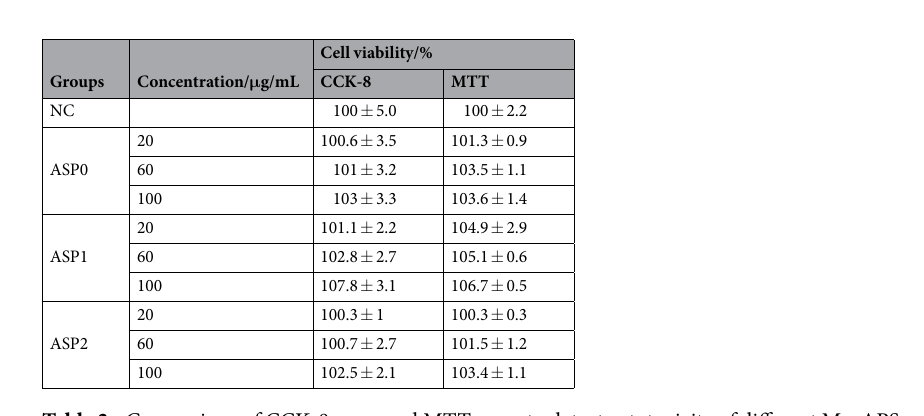
Table 2. Comparison of CCK-8 assay and MTT assay to detect cytotoxicity of different Mw APS on HK-2